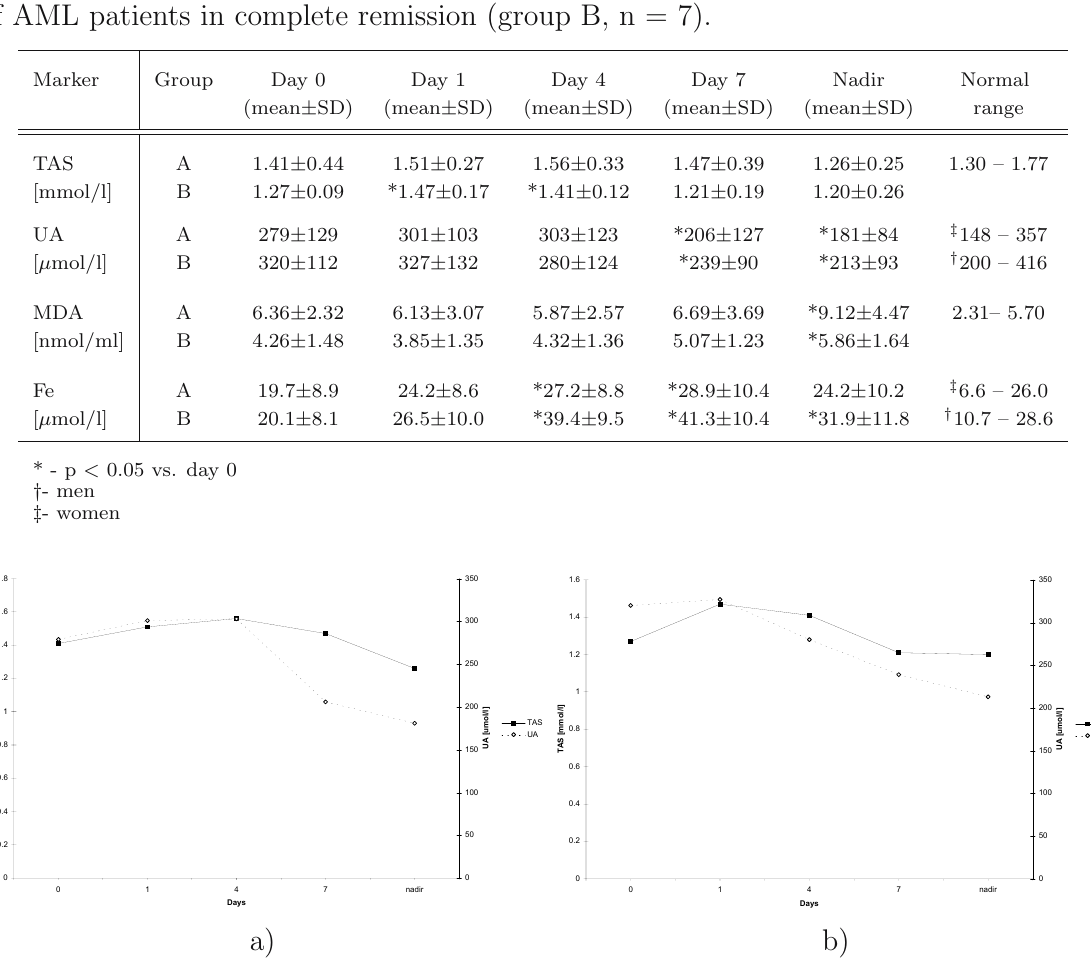
Fig. 1 Comparison between the changes in TAS and uric acid average values in AML patients during chemotherapy